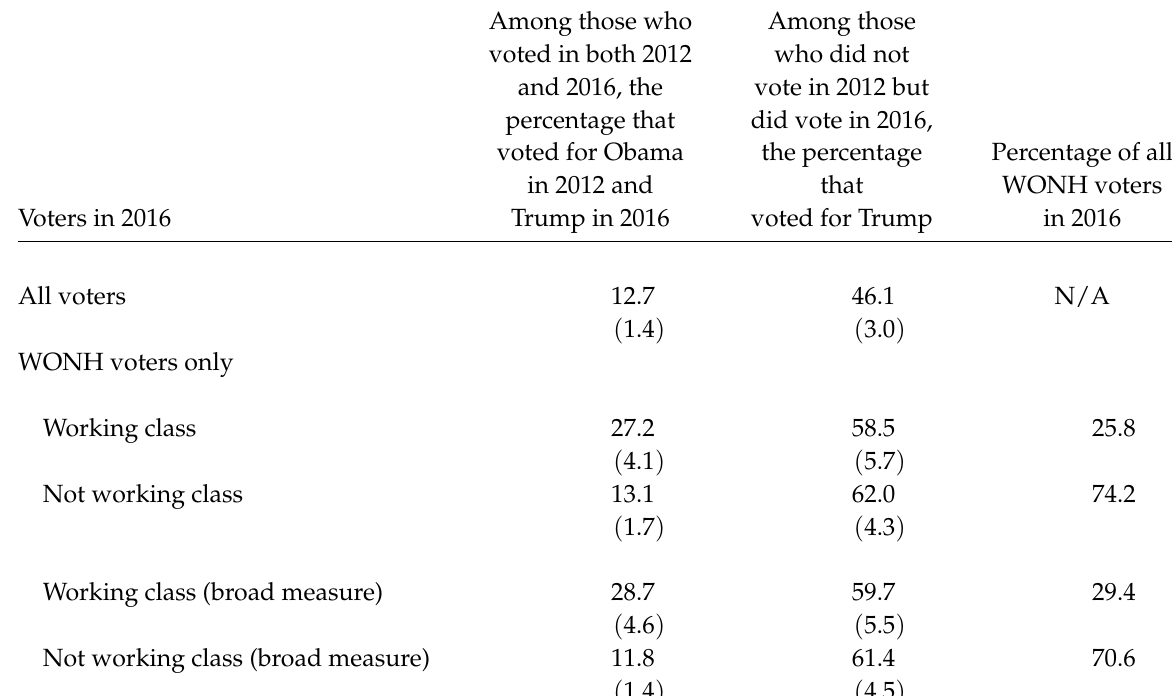
Table 1: Components of Trump’s voters in 2016. Among those who Among those voted in both 2012 who did not and 2016, the vote in 2012 but percentage that did vote in 2016, voted for Obama the percentage Percentage of all in 2012 and that WONH voters Voters in 2016 Trump in 2016 voted for Trump in 2016 12.7 46.1